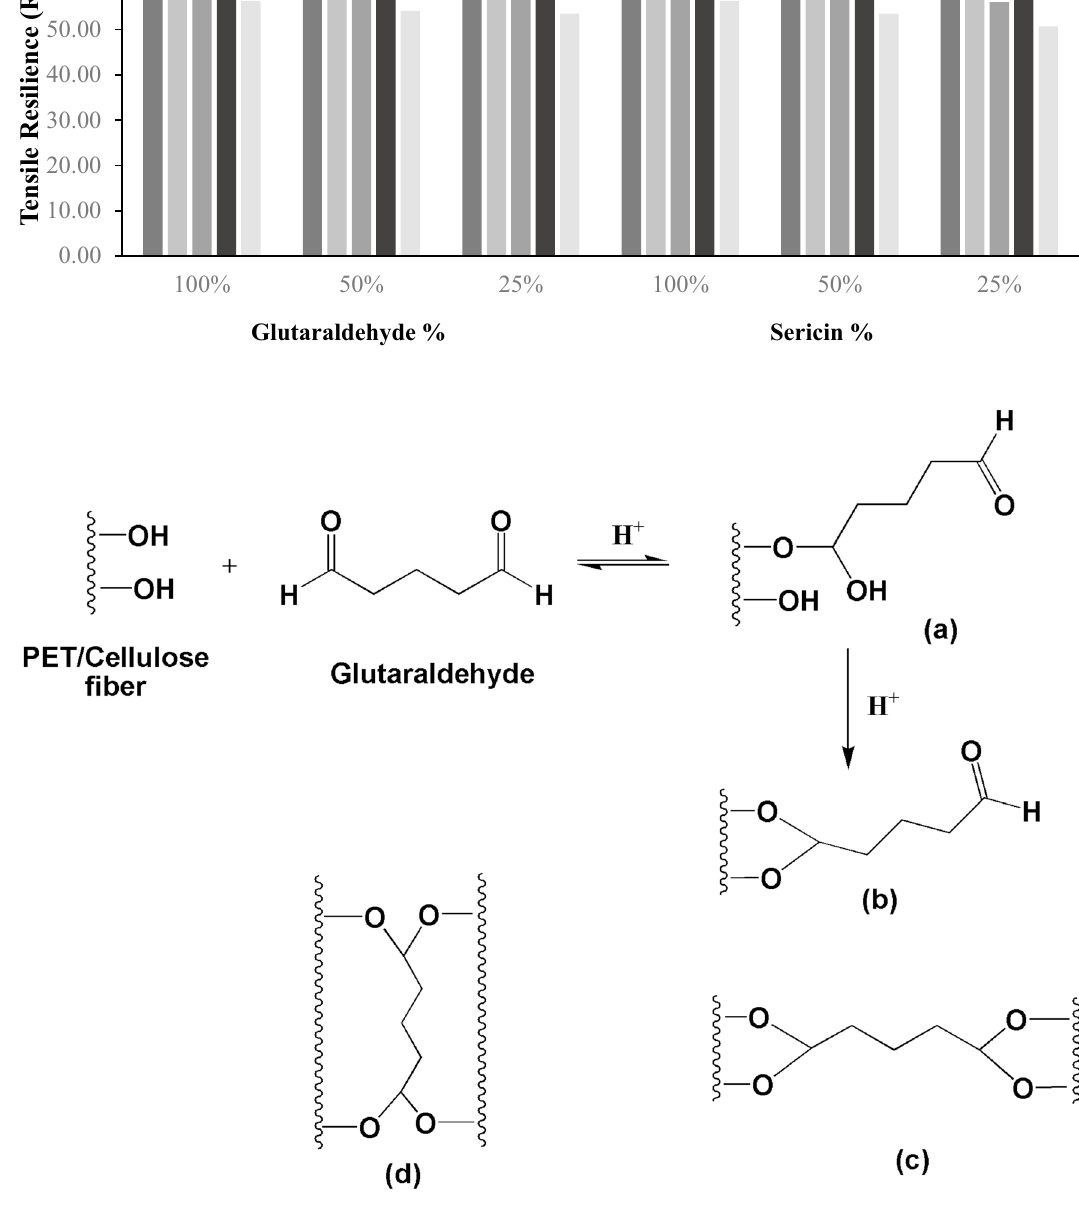
Figure 4. Tensile resilience (RT) % of samples. ( a – d ) Possible ways of fixation of glutaraldehyde on the fabric